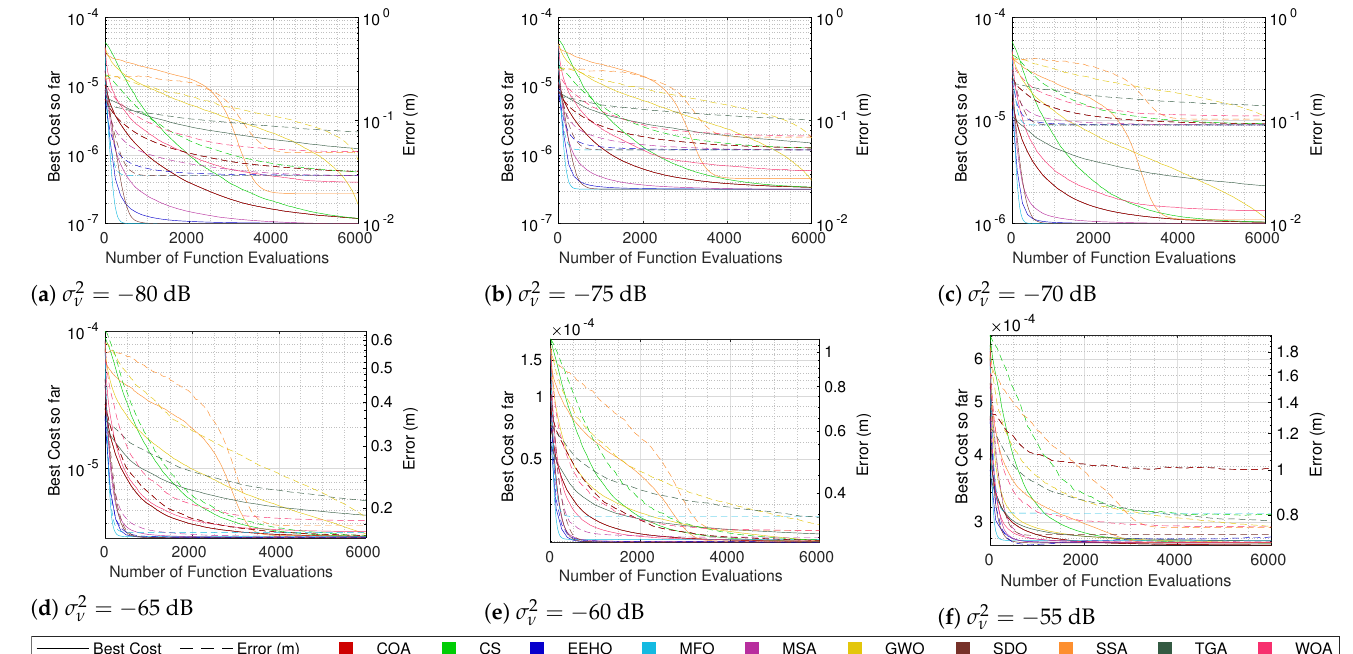
Figure 5. Cost convergence and respective error for each algorithm when N = 12.